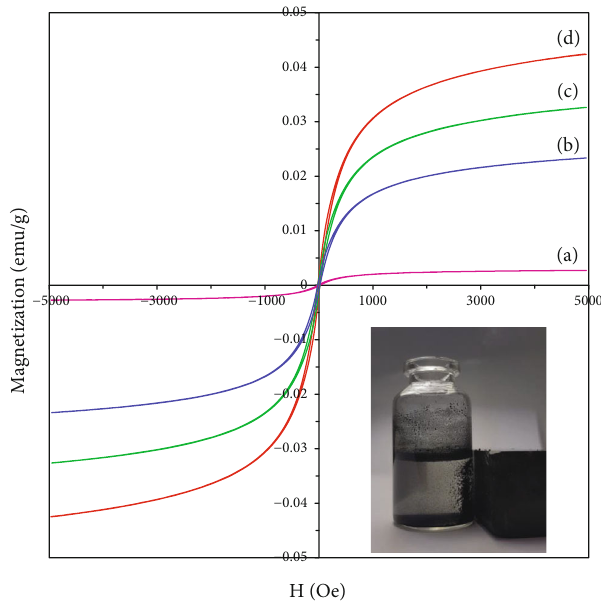
Figure 7: Magnetization vs. applied magnetic fi eld for MHT (a), 2 Pan/MHT (b), 1 Pan/MHT (c), and 0.5 Pan/MHT (d). Table 1: Magnetic parameters of MHT and Pan/MHT composites.